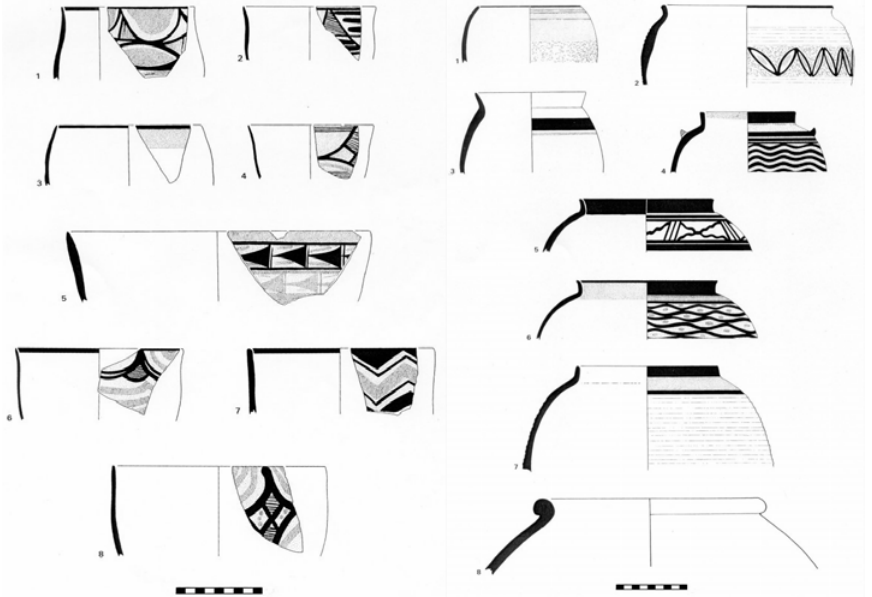
Figure 4. Ceramics typical of the Kot- Diji phase at